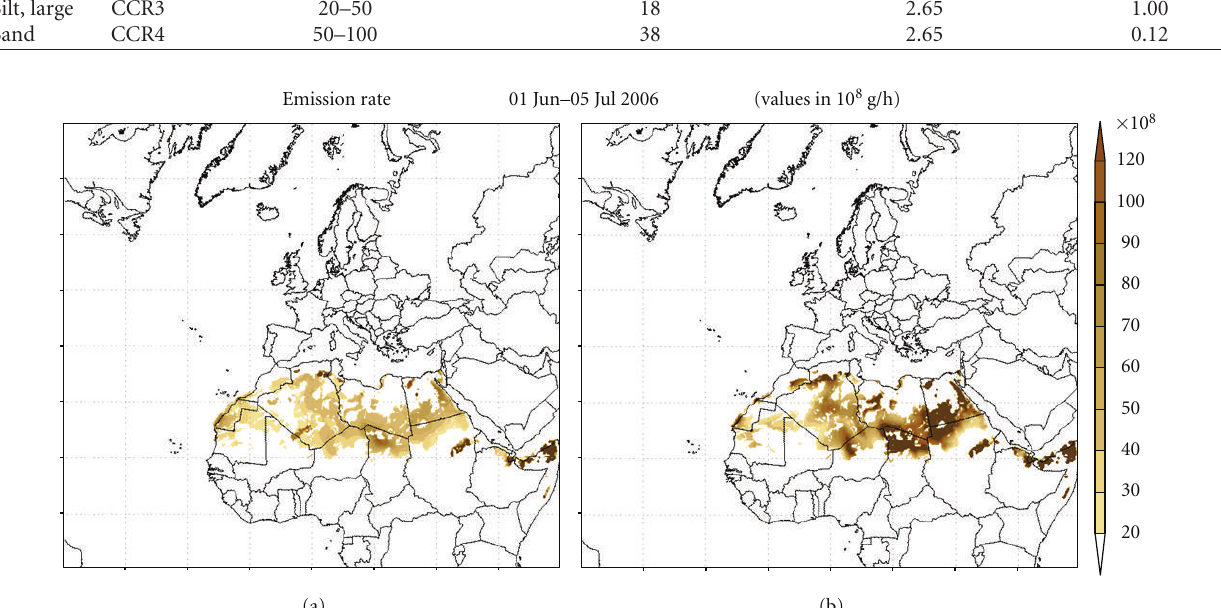
Figure 1: Emission rate, cumulated on the period 01–05 June 2006 for the first dimensional class (a) and for the second dimensional class